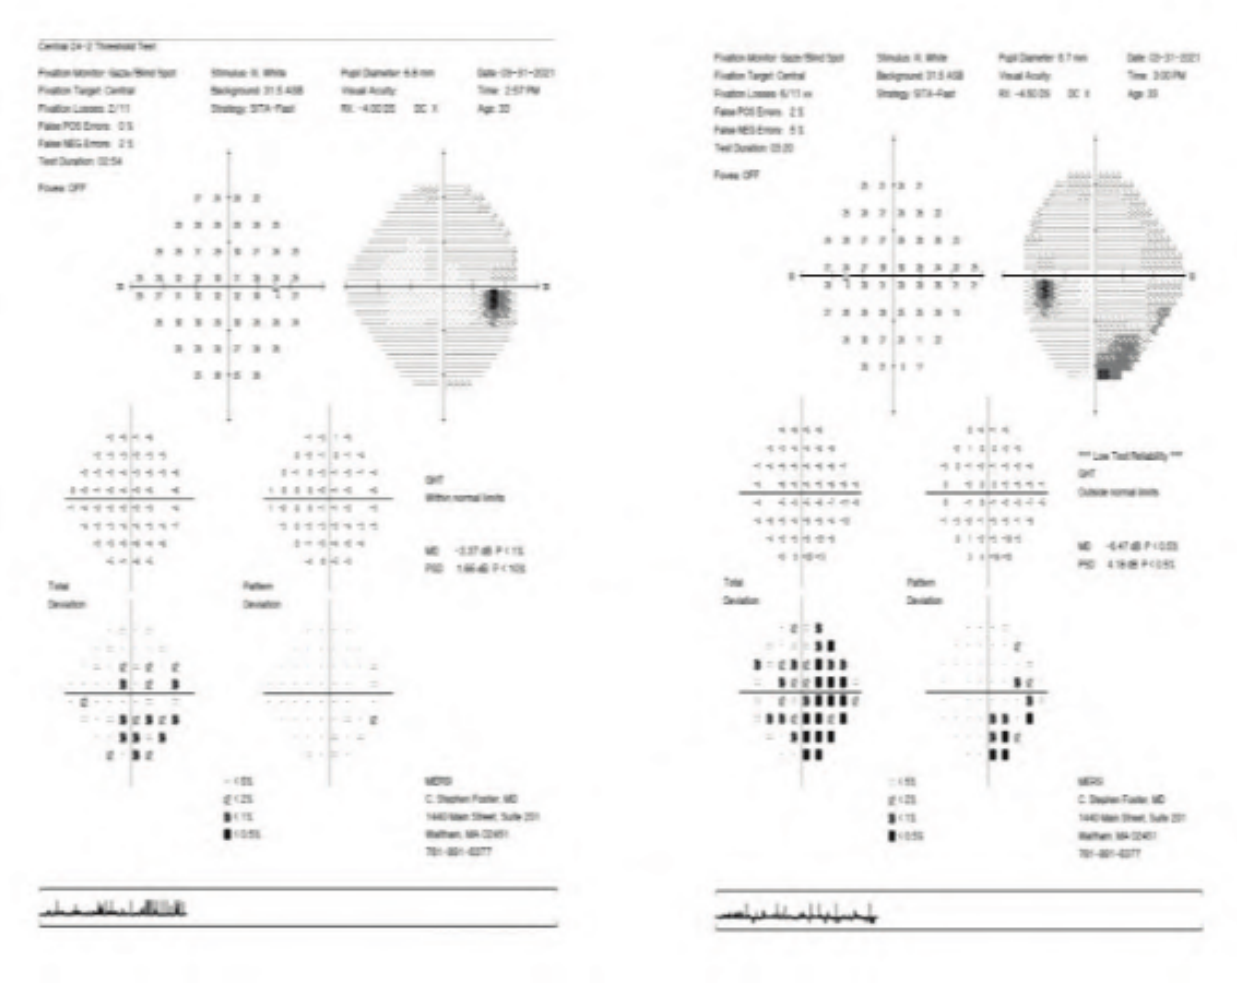
Figure 6. The left and right images are Humphrey visual field 24-II of the right and left eyes, respectively. The right eye visual field is reliable and shows a nonspecific nasal defect. The left eye visual field is unreliable and shows an impressive nasal field